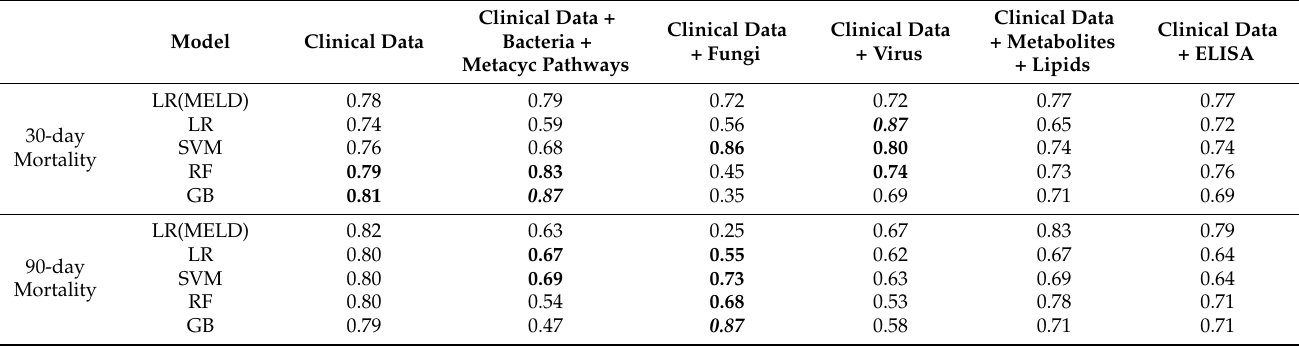
Table 3. Summary of AUC scores for each dataset.